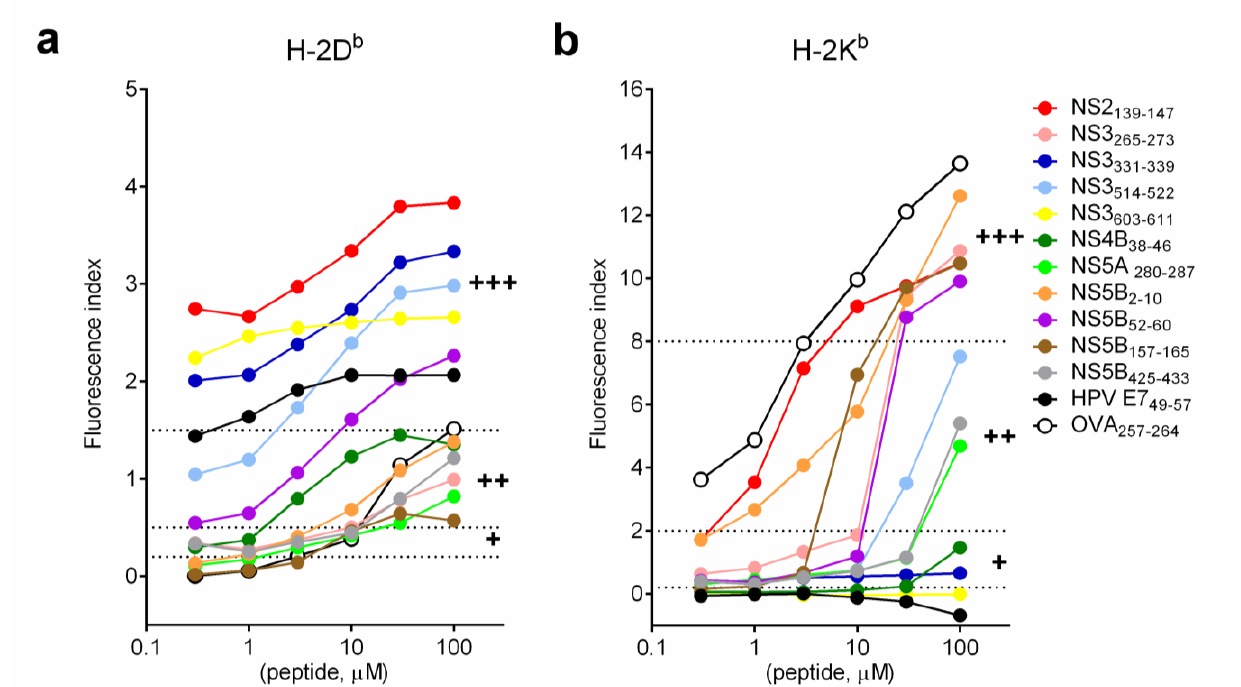
Figure 2. Binding affinity of HCV short peptides to MHC class I molecules. Short synthetic HCV peptides were serial diluted and incubated with RMA-S cells as described in Figure 1. ( a ) H-2D b ; ( b) H-2K b . Dash lines indicate the cutoff values for H-2D b (0.2–0.5: weak binders (+); 0.5–1.5: intermediate binders (++); >1.5: strong binders (+++)) and H-2K b (0.2–2: weak binders (+); 2–8: intermediate binders (++); >8: strong binders